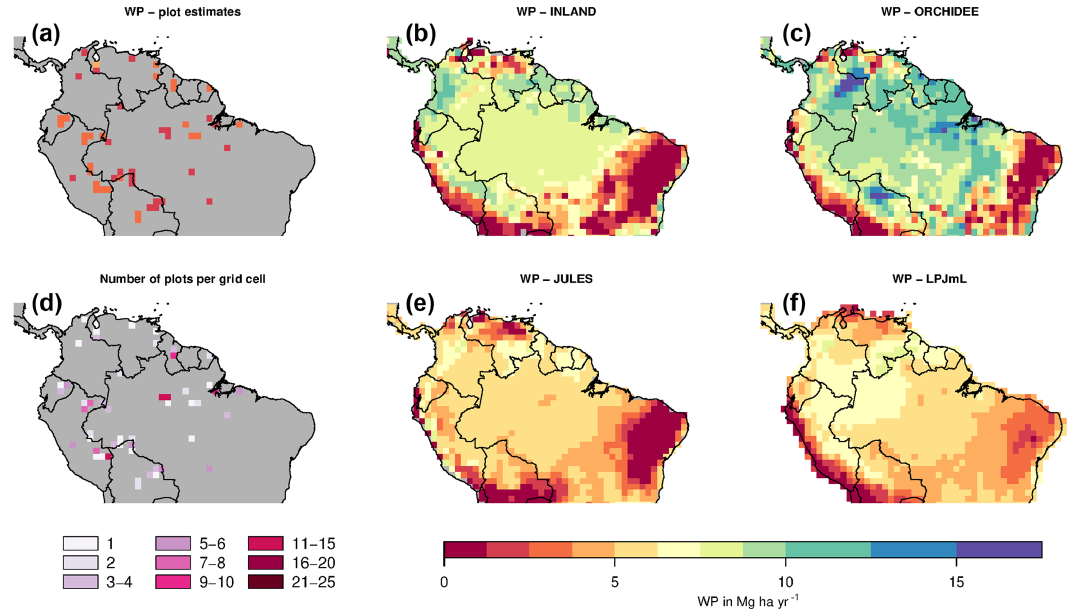
Figure 6. Estimates of aboveground woody productivity (WP) from forest plots in 1 ◦ × 1 ◦ pixels. (a) Mean WP from inventory plots; (b) number of plots per pixel; and (c–f) simulated WP from four DGVMs.